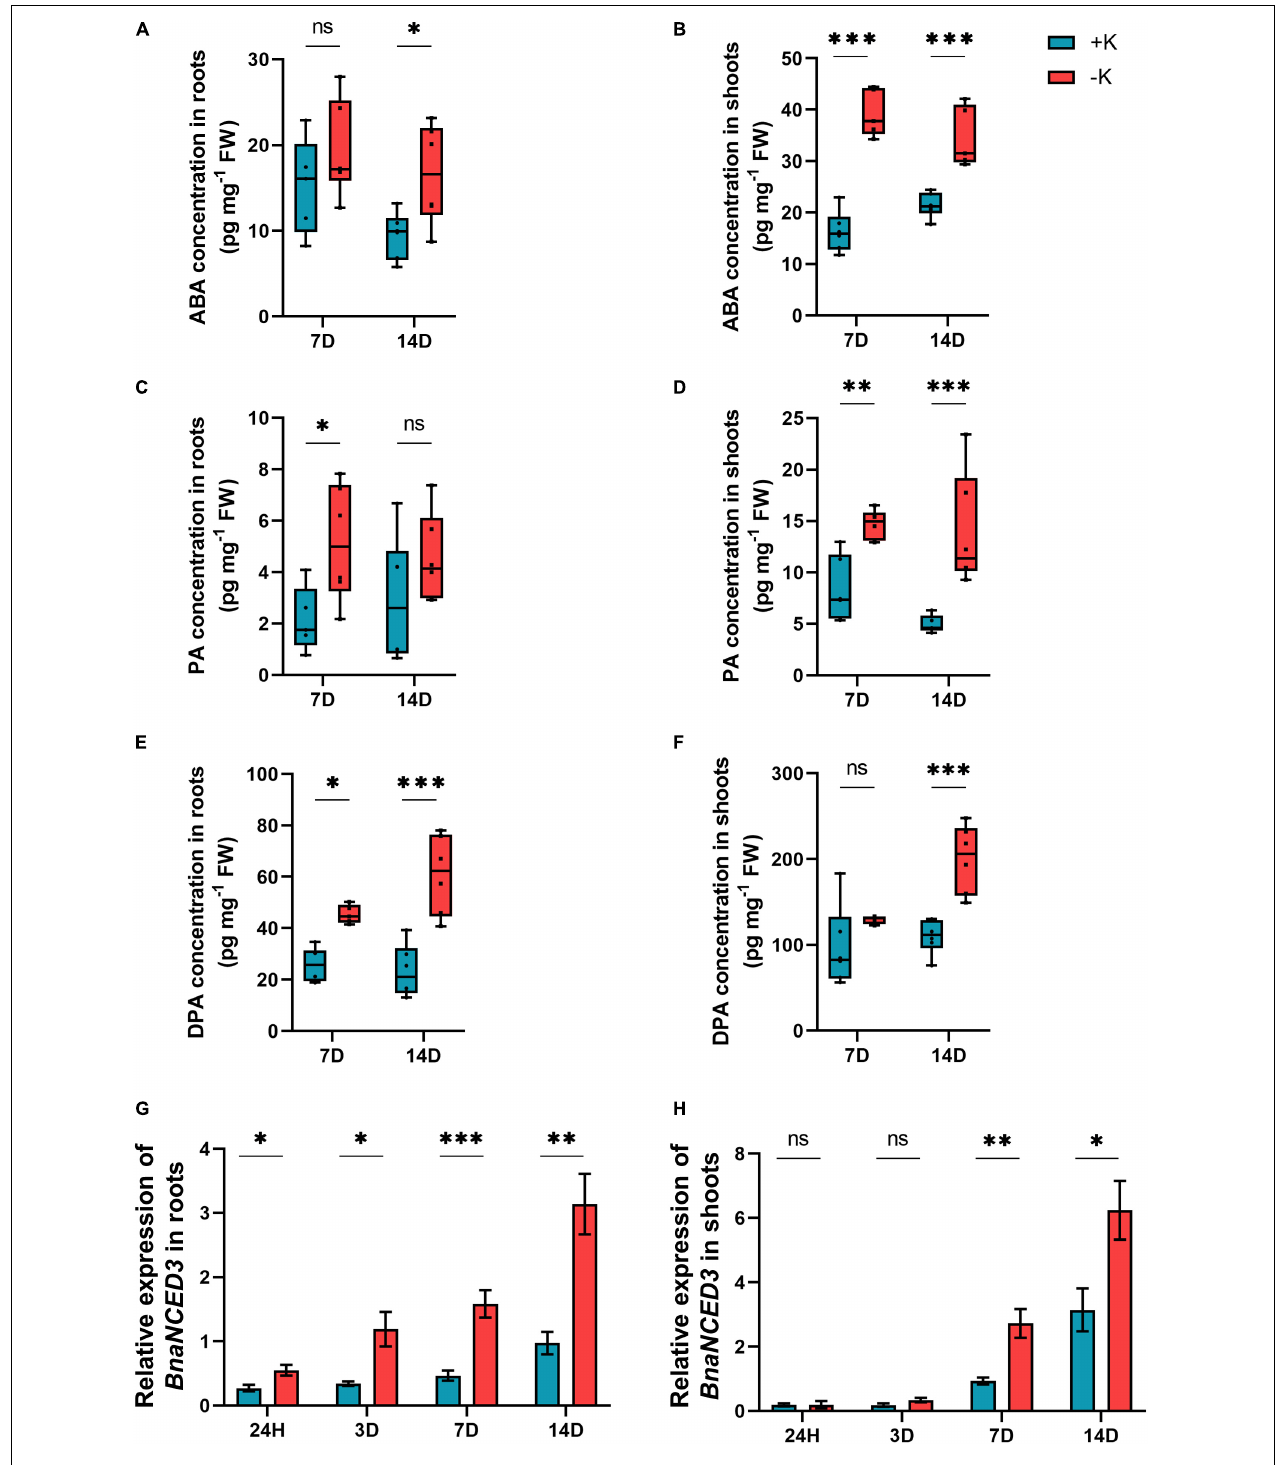
FIGURE 8 | Influence of K deficiency on ABA level and the key genes involved in ABA biosynthetic pathway in rapeseed. (A) ABA concentration in roots; (B) ABA concentration in shoots; (C) phaseic acid (PA) concentration in roots; (D) PA concentration in shoots; (E) diphaseic acid (DPA) concentration in roots; (F) DPA concentration in shoots; (G) relative expression of BnaNCED3 in roots and (H) relative expression of BnaNCED3 in shoots. Plants were grown in a hydroponic culture under either –K (0 mM) or + K (2 mM). The roots and shoots were harvested after 24 h, 3, 7, or 14 days of K deprivation. Bars indicate mean ± standard error of the mean (SEM) ( n = 6). Asterisks denote the significant level of the difference according to t -test ( ∗ p < 0.05, ∗∗ p < 0.01, and ∗∗∗ p < 0.001, n = 6). Ns denotes non-significant differences.